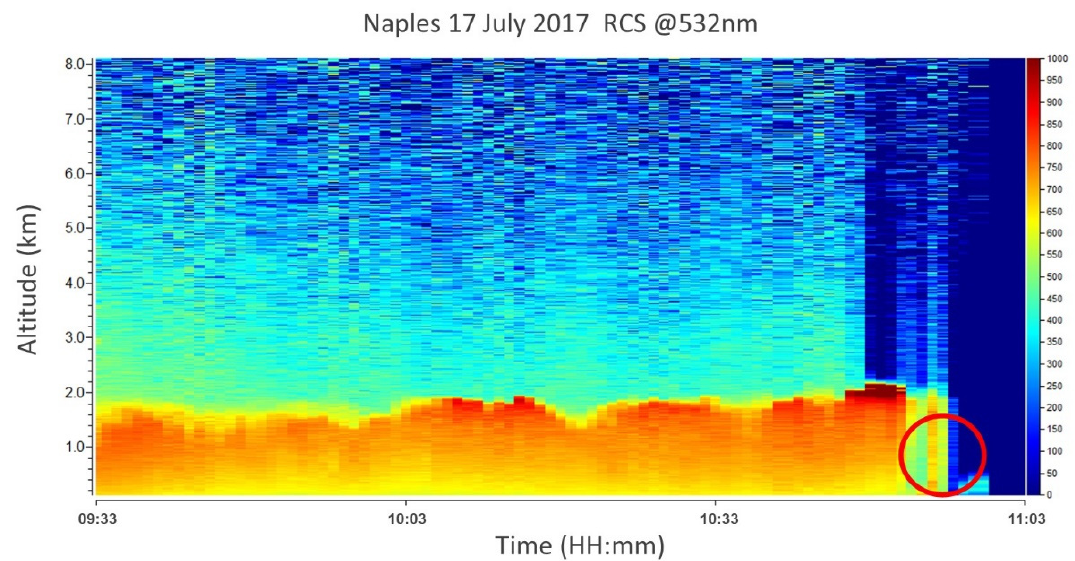
Figure 17. Time variability of the RCS lidar signal retrieved at 532 nm on 17 July 2017 from 09:33 to 11:03 UTC. Reported data have a spatial resolution of 15 m and a temporal resolution of 60 s.